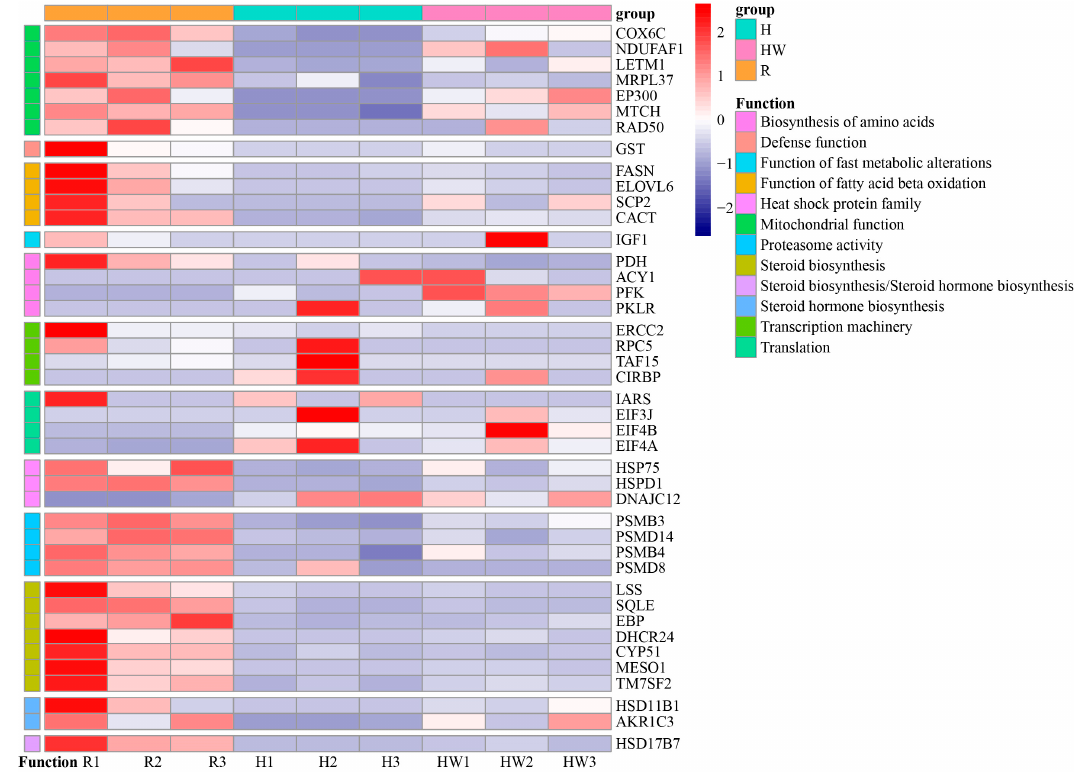
Figure 5. Heat map of different genes with detailed function in different samples. R: room temperature, H: high temperature, HW: heat wave.